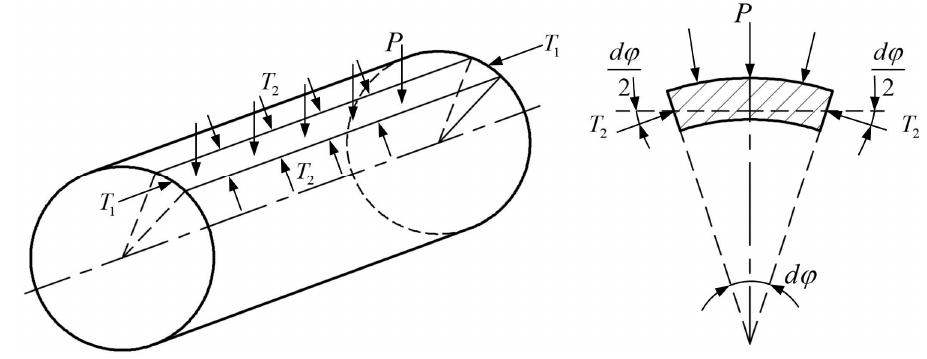
Figure 4. Schematic diagram of the slicing unit force.